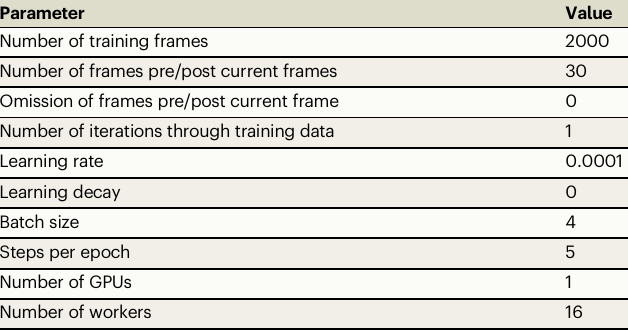
Table 1 | Training parameters for